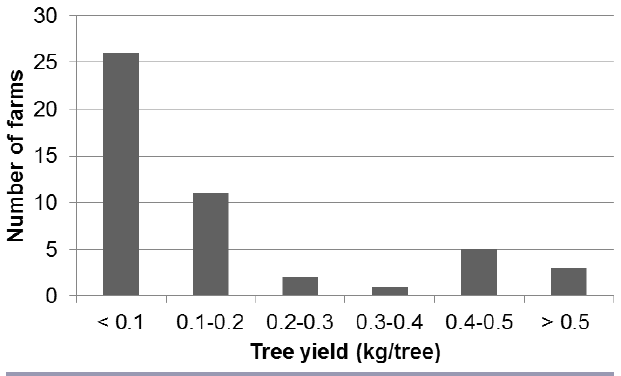
Fig. 1 . Mean Jatropha seed yields per tree (air-dried as sold) reported by BERL smallholders (based on the first season harvest until the time of the survey in March 2013).